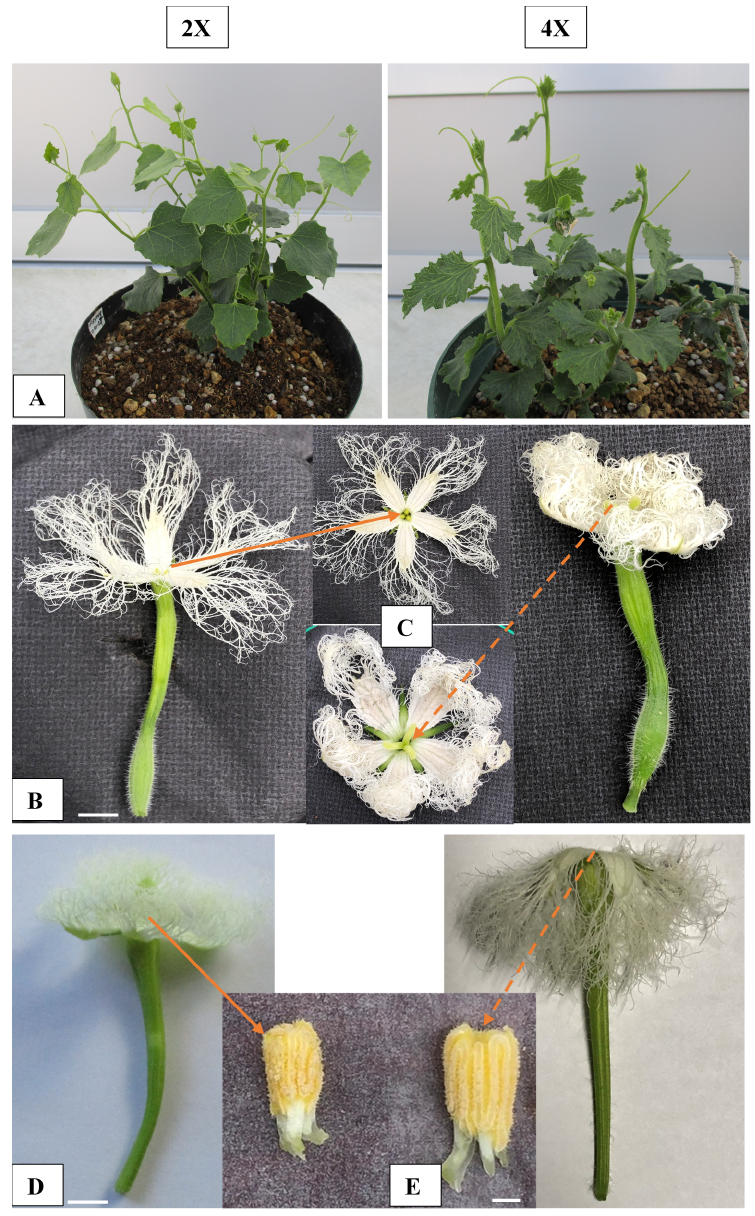
Figure 5. Vegetative and reproductive traits of the diploid and colchicine-induced tetraploid plants of pointed gourd grown in 2019. The diploid (2x) plant is presented on the left side and the tetraploid (4x) is on the right side. ( A ): Shoots regenerated from the previous year’s grown mature vine cuttings; ( B ): female flower; ( C ): petals and stigma; ( D ): male flower; ( E ): anther of the diploid plant (left side) showing smaller features compared to the colchicine induced tetraploid plant on the right hand side. Straight lines indicate the diploid stigma and anther; while the dashed lines indicate tetraploid stigmas and anthers. The bar indicates 1 cm (female flower), 5 mm (male flower), and 1 mm (anther).